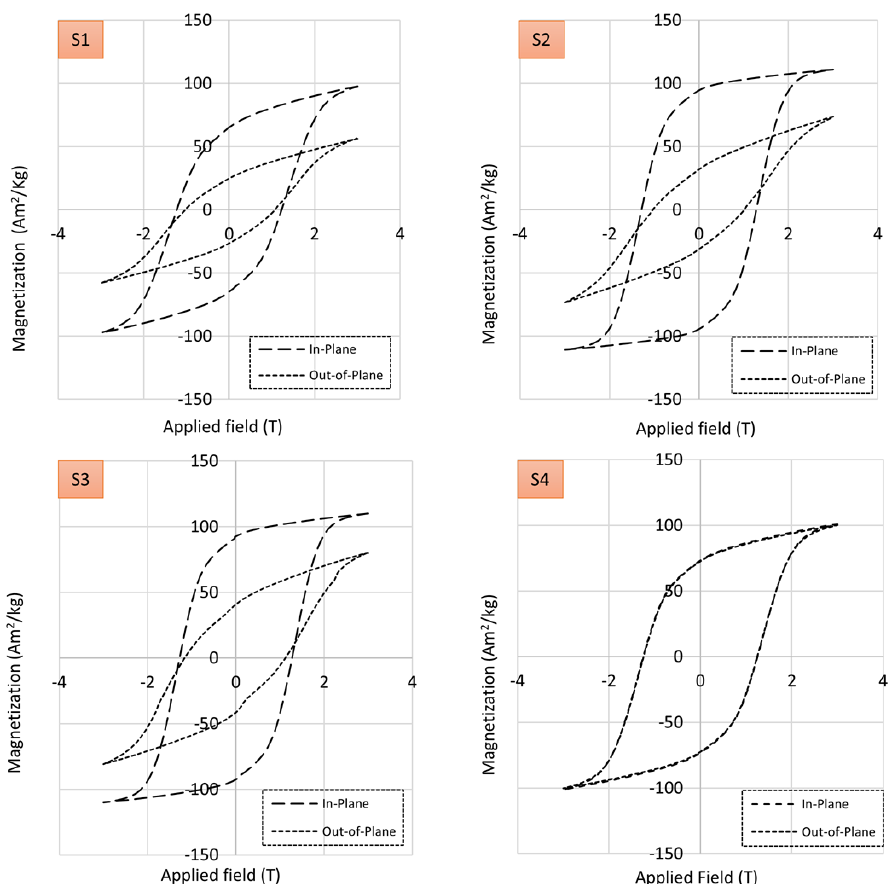
Figure 13. Hysteresis loops of magnetic composites as listed in Table 1, measured in sample in-plane and out-of-plane orientation using a vibrating sample